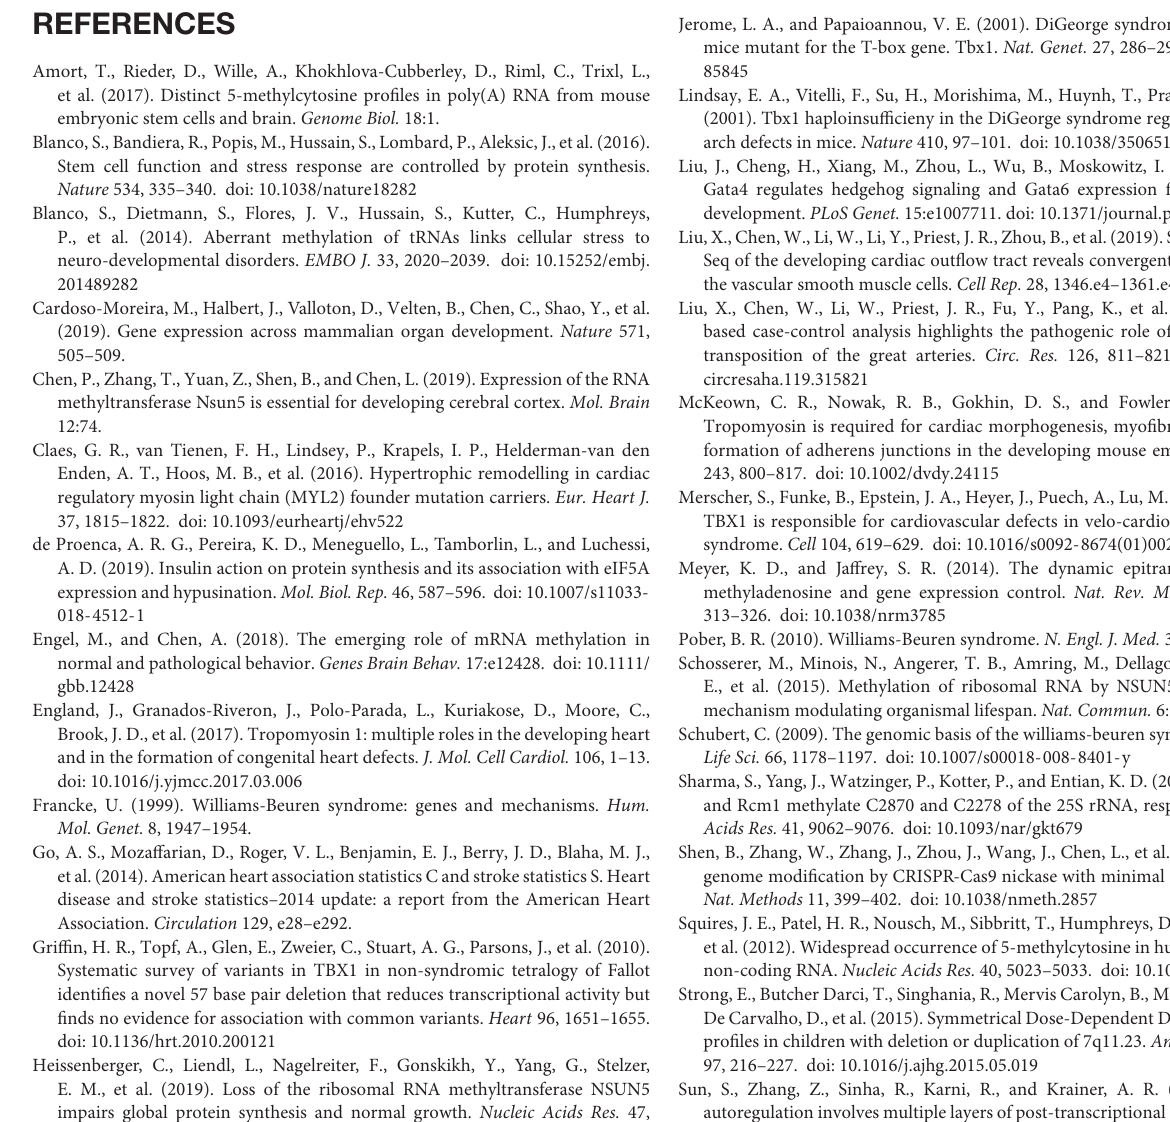
hearts. n = 3/group. (B) The protein expression of Cox4i1 confirmed by western blot in E14.5 Nsun5 hearts. n = 3/group. One-way ANOVA test was used for statistical calculation. ∗∗ P < 0.01. Supplementary Figure 9 | The Nsun5 spatiotemporal expression pattern. (A) The Nsun5 spatiotemporal expression pattern in mRNA level at E12.5 E14.5, E16.5, and P1 with multiple tissues. (B) The Nsun5 spatiotemporal expression pattern in protein level at E12.5 E14.5, E16.5, and P1 with mouse embryo hearts. Supplementary Figure 10 | The Tpm1 expression in OFT cell types. Various OFT cell types expressed Tpm1 in public single cell RNA-seq data. Supplementary Figure 11 | Full western blot membranes in the study. (A) Full western blot membrane for NSUN5 expression assay in different mutant forms. (B) Full western blot membrane for Nsun5 spatiotemporal expression in mouse embryo hearts. (C) Full western blot membrane for Nsun5 and Myl2 expression assay in E14.5 hearts. (D) Full western blot membrane for Tpm1 expression assay in E14.5 hearts. (E) Full western blot membrane for Cox4i1 expression assay in E14.5